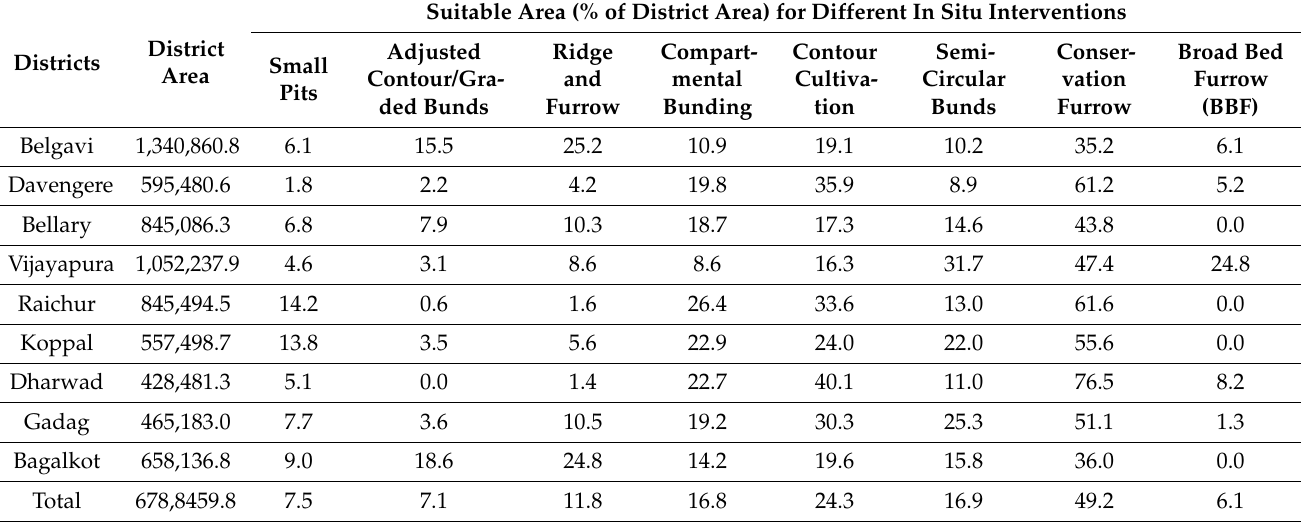
Table 5. Prioritization of different in situ interventions for northern dry zone of Karnataka.